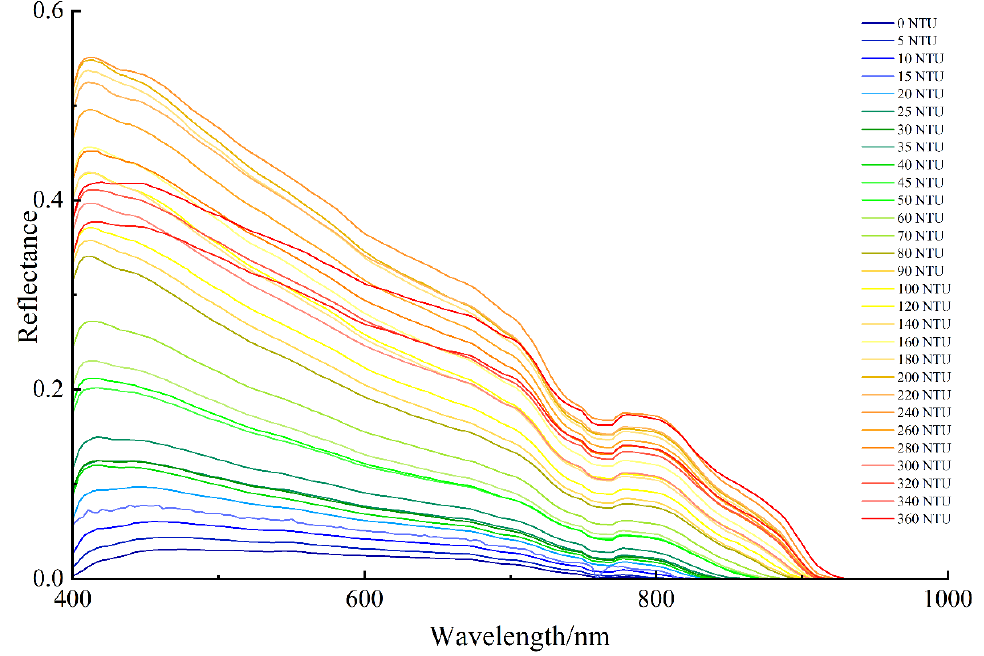
Figure 5. Reflectance curve of hyperspectral imager turbidity standard solution.